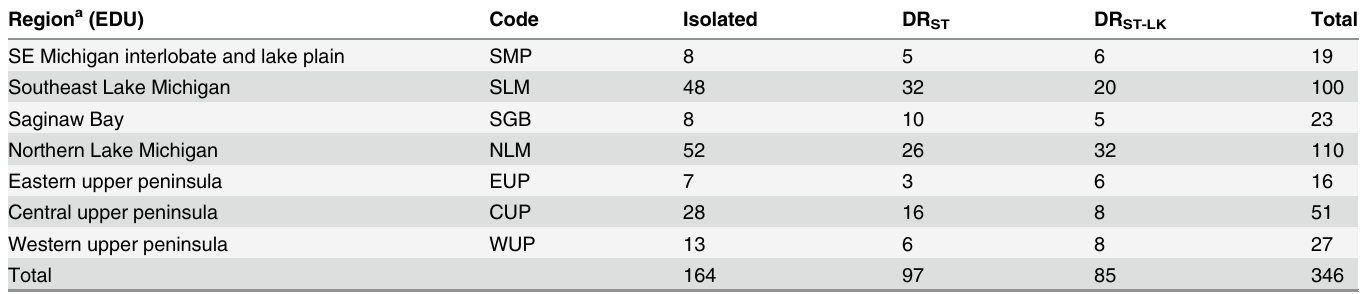
Table 1. Numbers of study lakes by hydrologic lake class within each